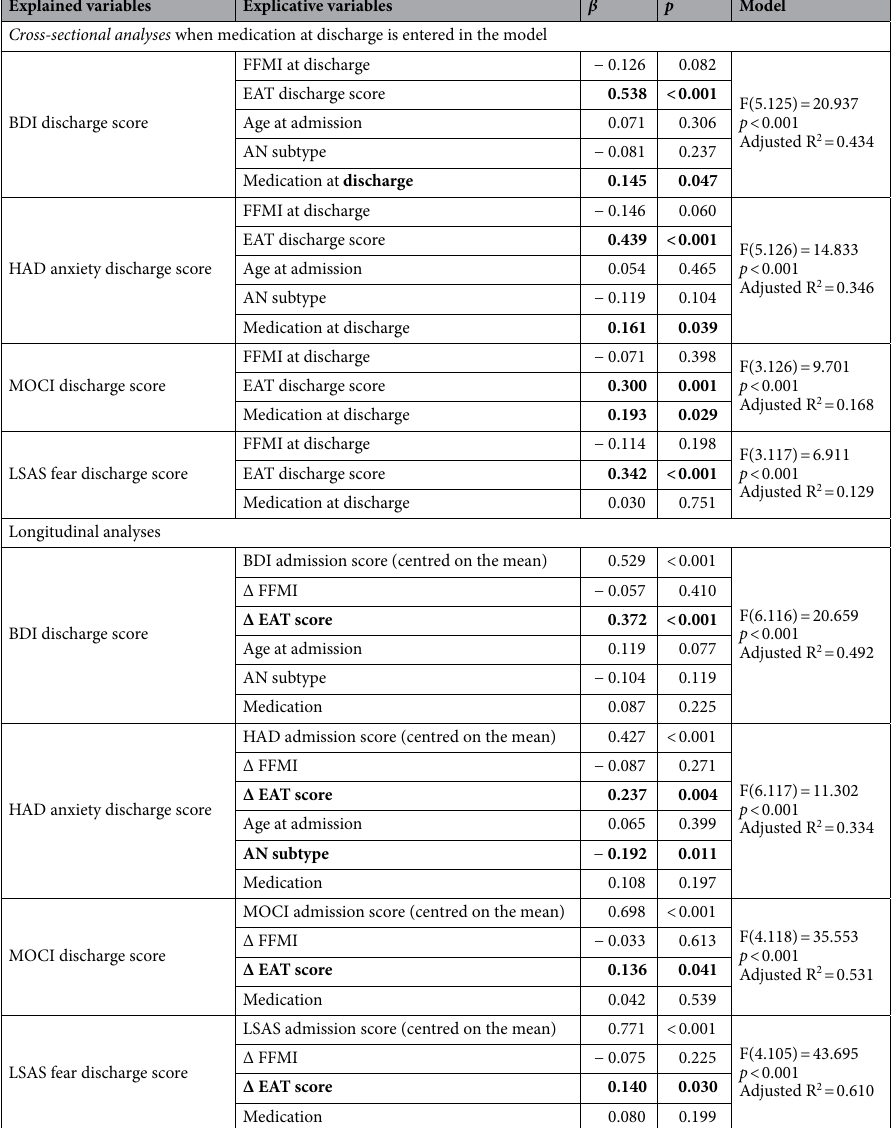
Table 5. Multivariate analyses: results. Bold: Significant associations. BDI Beck’s Depression Inventory, HAD Hospital Anxiety and Depression scale, MOCI Maudsley Obsessive–Compulsive Inventory, LSAS Liebowitz Social Anxiety Scale, BMI Body Mass Index, EAT Eating Attitude Test, AN anorexia nervosa, ∆ variation of variable (admission minus